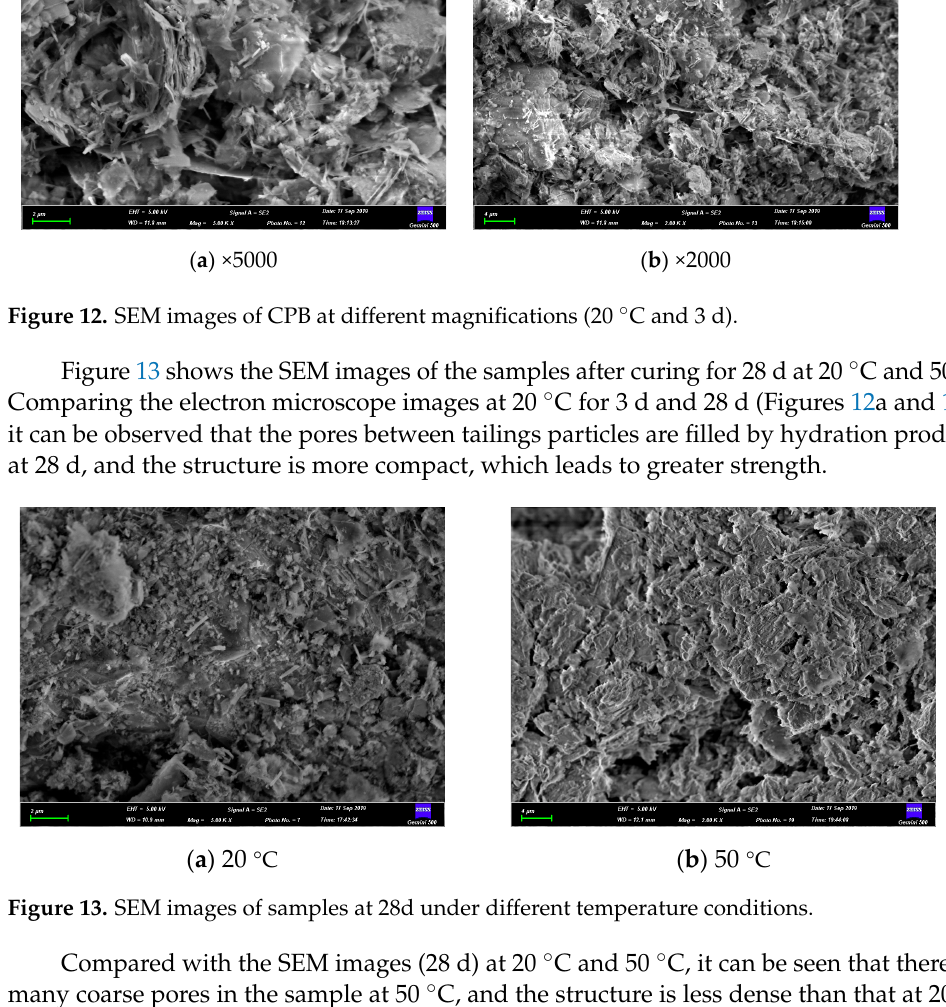
Figure 14. Variation law of porosity of CPB under different curing temperatures. 20